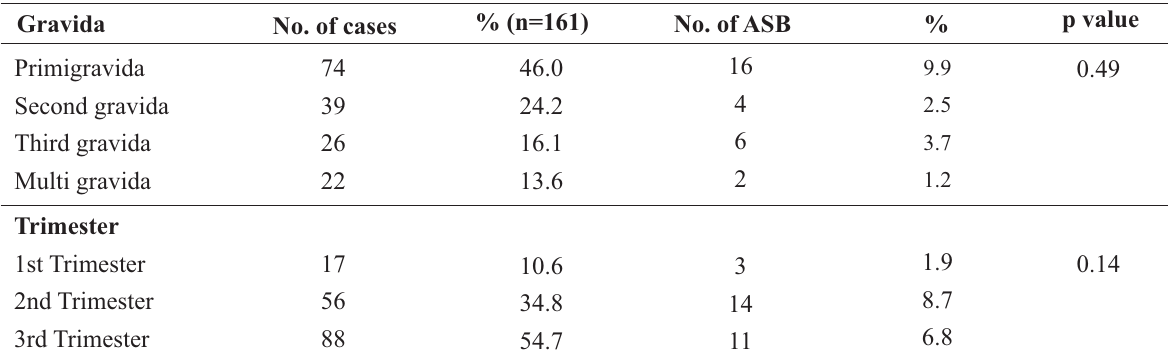
Table 2: Distribution of cases according to gravida and trimester